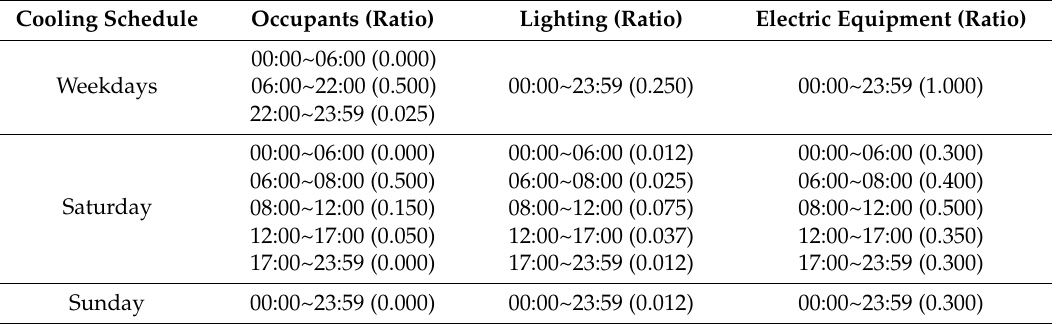
Table 6. Simulation conditions.